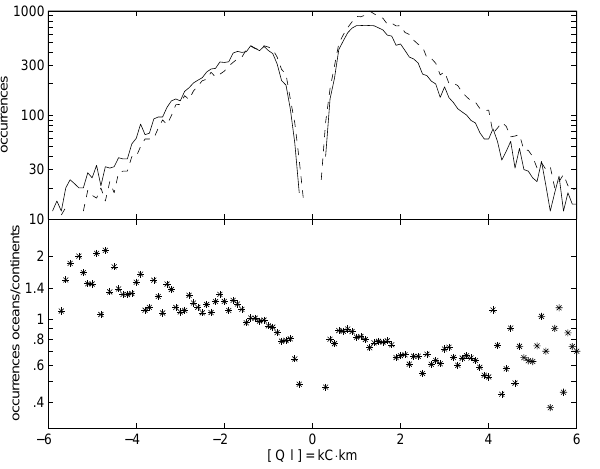
Fig. 3. The charge moment distribution functions of particularly intense oceanic (solid lines) and continental (dashed lines) lightning discharges indicate that negative oceanic lightning discharges are more likely to occur than negative continental lightning discharges (upper panel). The ratio between the oceanic and the continental charge moment distribution function is linearly related to the charge moment (lower panel).